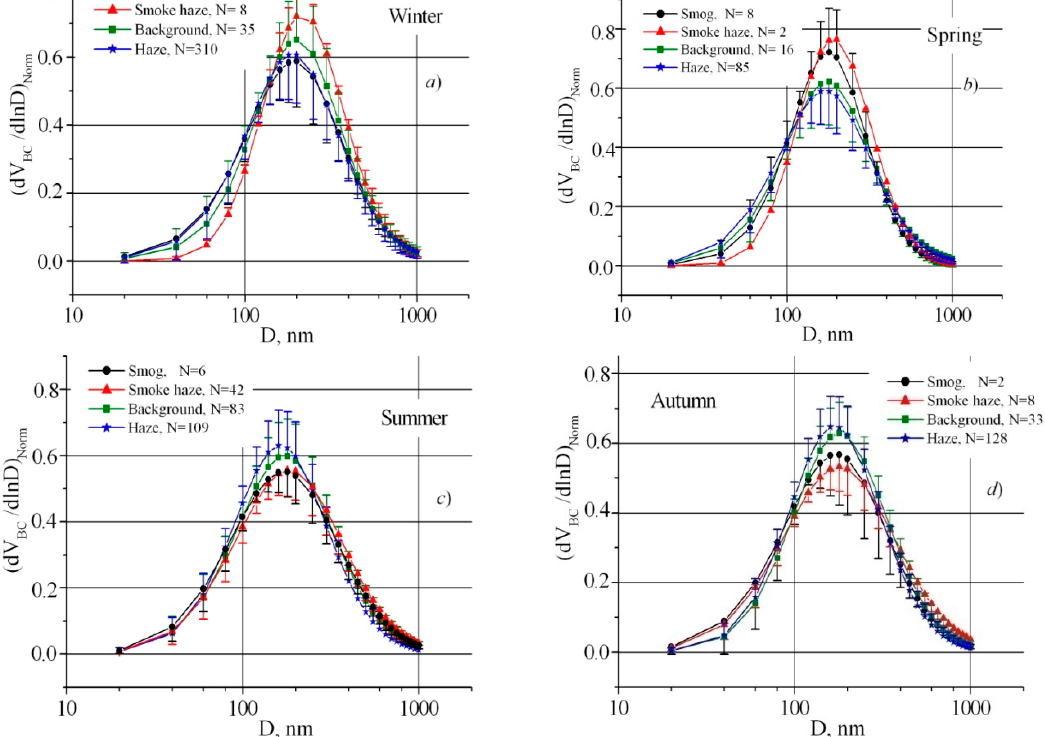
Figure 4. Seasonal average normalized size distributions of the absorbing substance in the different types of aerosol weather in winter ( a ), spring ( b ), summer ( c ), and autumn ( d ).